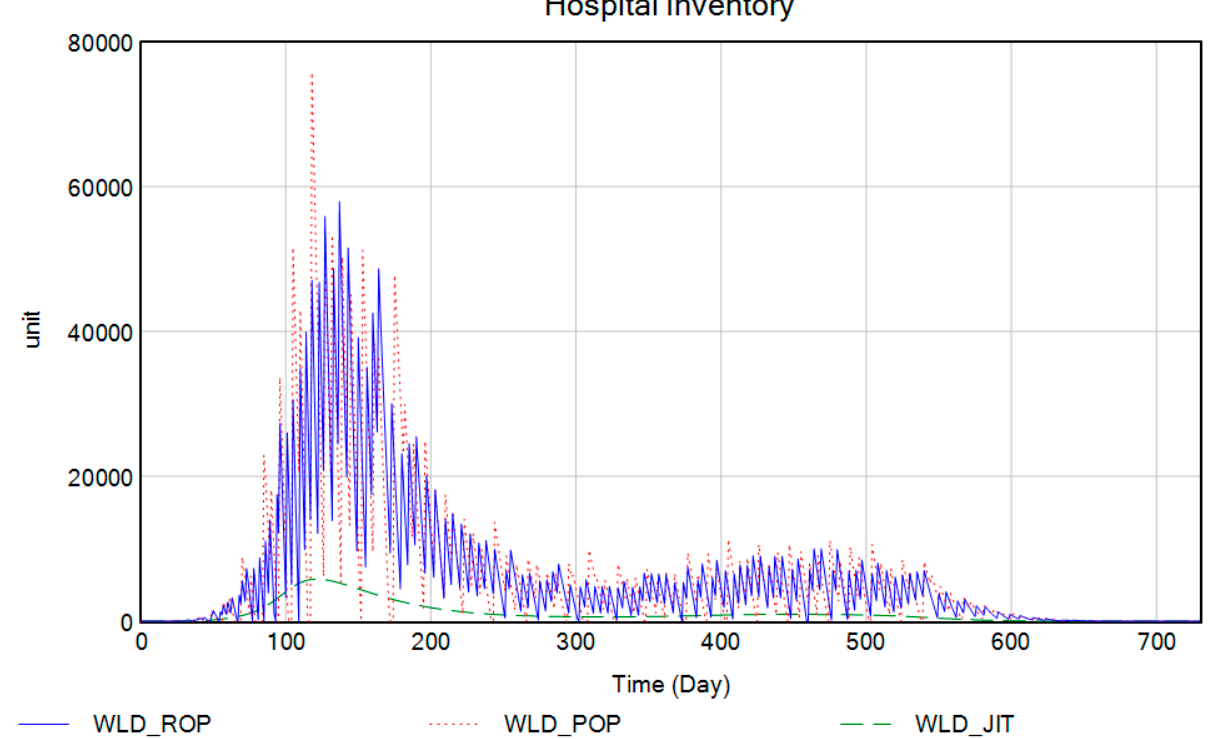
Figure 4. Comparison of inventory policies during WLD.